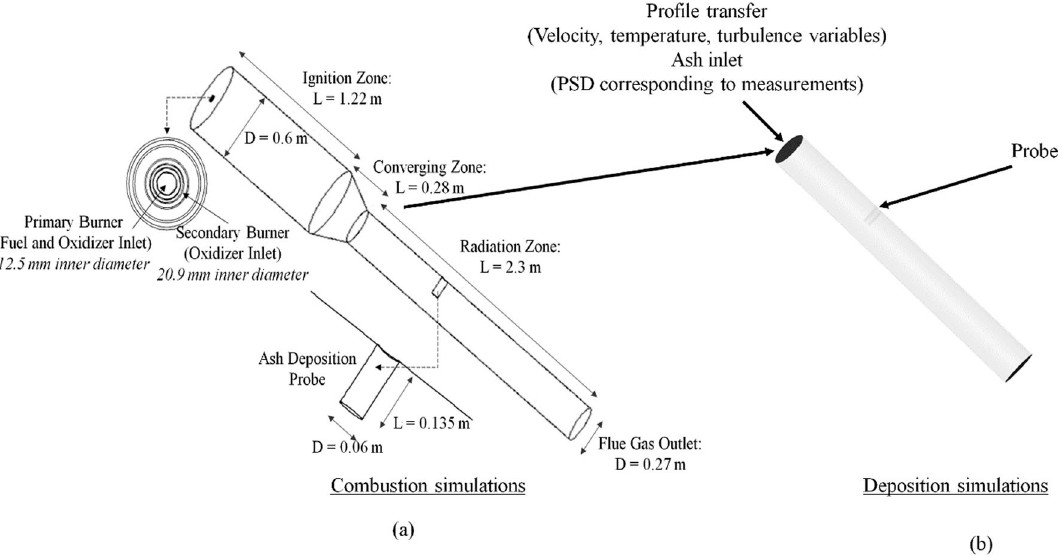
Fig. 1 Geometric details of the down flow OFC combustor. a Domain for combustion simulations b Domain (radiation zone only) for the ash deposition